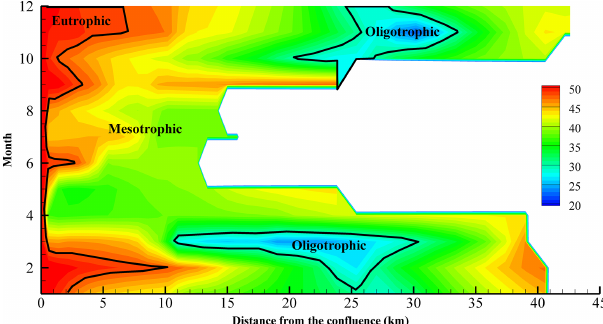
Figure 18. Eutrophication results of surface water in the tributary bay. The nutrient status of the tributary bay is divided into three states (oligotrophic, mesotrophic, and eutrophic) according to the comprehensive nutrient